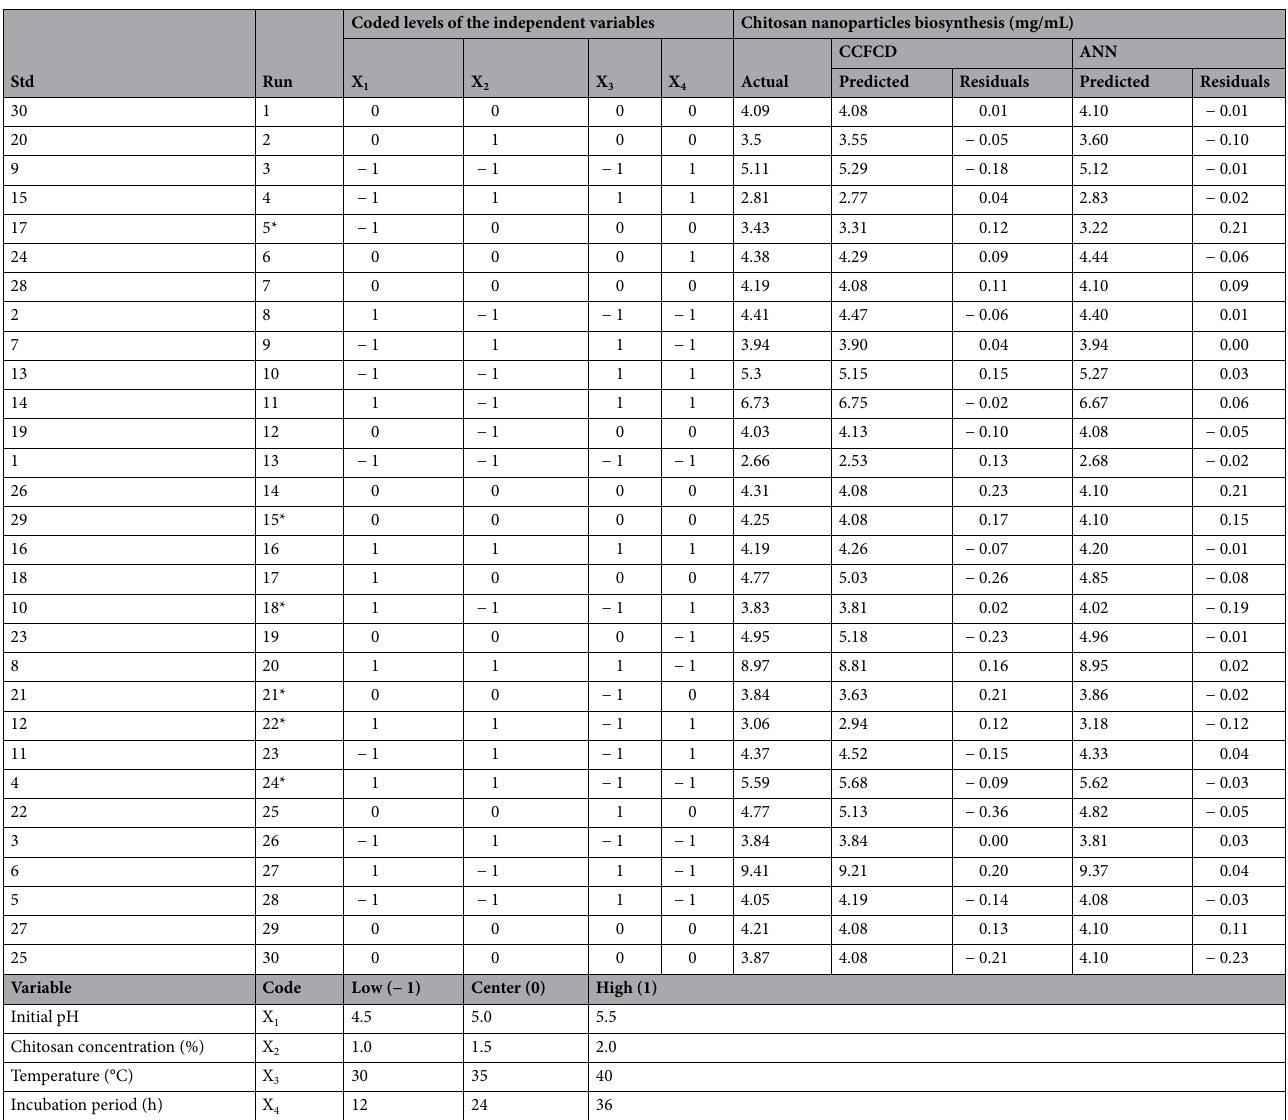
Table 2. Four-factors CCFCD matrix with the corresponding actual and predicted (CCFCD and ANN) values of chitosan nanoparticles biosynthesized by Streptomyces microflavus strain NEAE-83. *Six runs were chosen at random for validating the ANN model, while the remaining 24 runs were used for